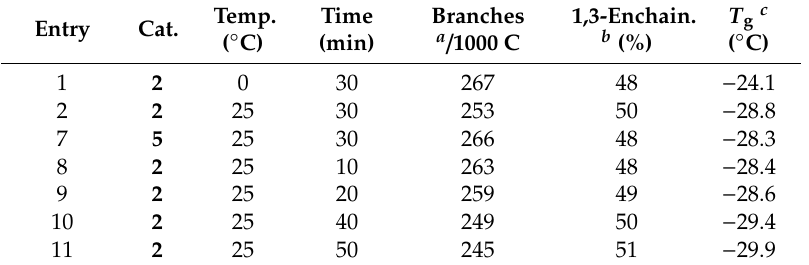
Figure 2. Plots of M n ( ■ ) and M w / M n ( ▲ ) versus polymerization time for propylene polymerization (( a ), 5 − 50 min, Table 1) and copolymer yield for P/1-decene copolymerization (( b ), Table 3) catalyzed by 2 -MMAO at 25 °C.